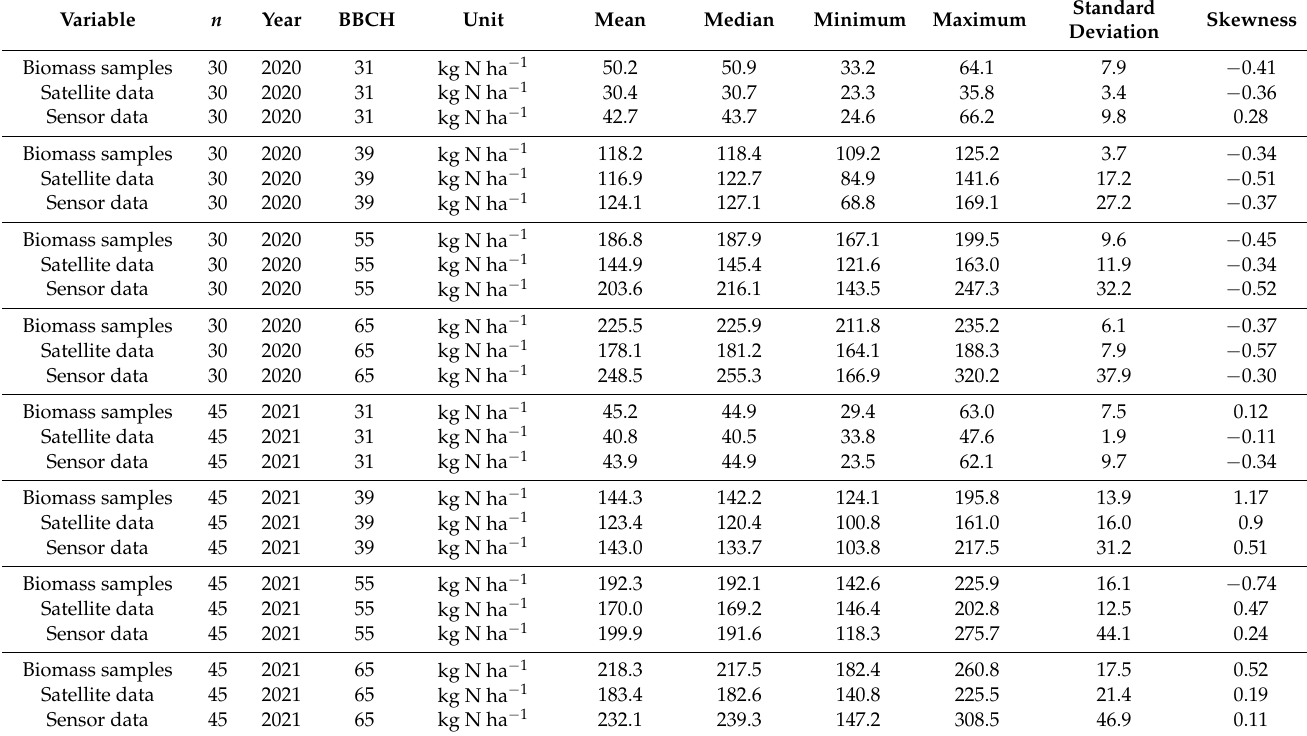
Table 4. Descriptive statistics of the nitrogen uptake data in kg N ha − 1 analyzed in this